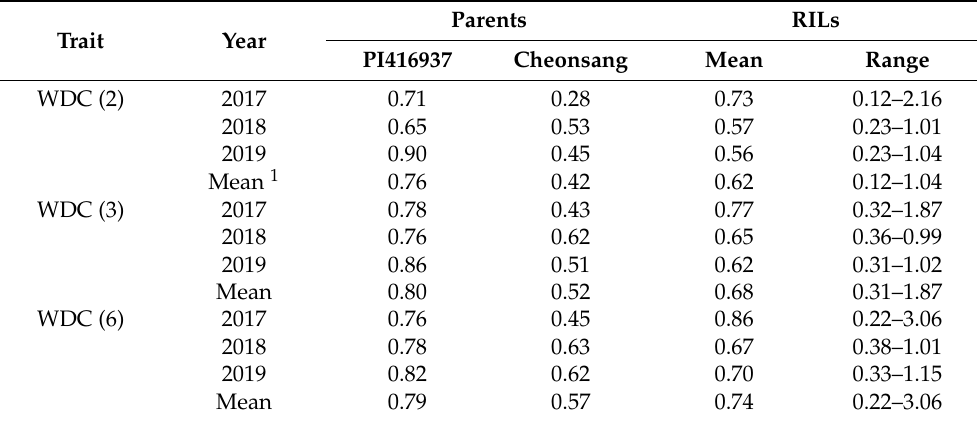
Table 1. Weighted drought coefficient (WDC) of the parents and recombinant inbred lines (RILs) for three years (2017–2019) and their